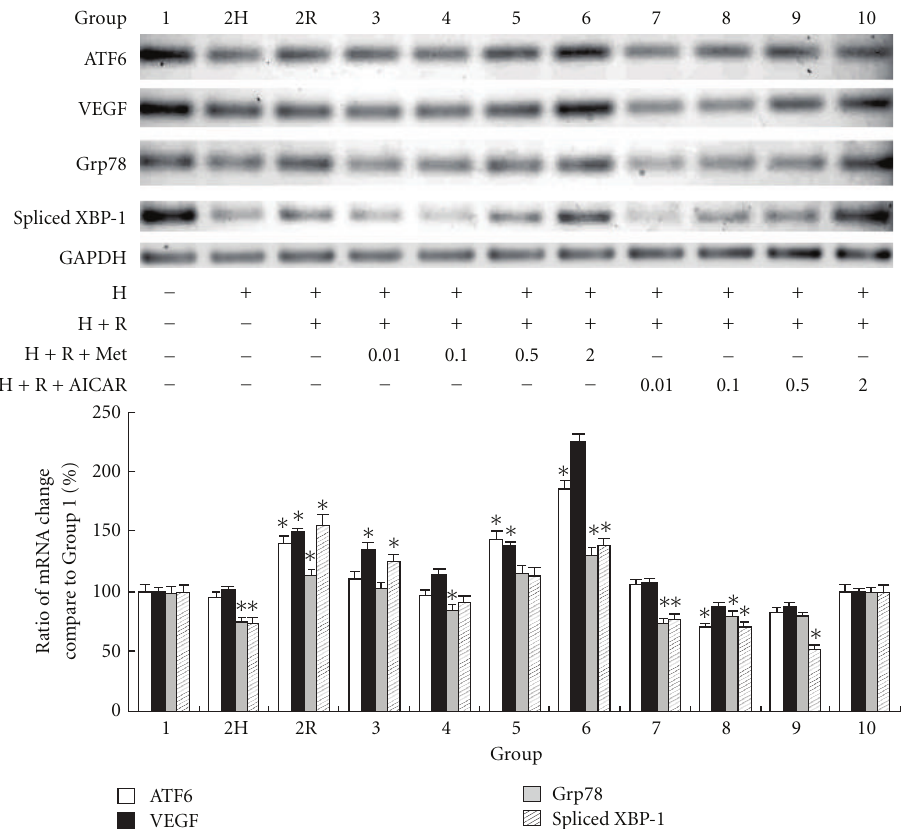
Figure 3: Reverse transcription PCR analysis showed up-regulation of ATF6, VEGF, Grp78, and spliced XBP-1 mRNAs in HL-1 cardiomyocytes from di ff erent groups. Glyceraldehyde-3-phosphate dehydrogenase (GAPDH) served as the loading control. The PCR products of GAPDH, ATF6, VEGF, Grp78, and spliced XBP-1 were designed to be around 200bp. Quantitative real-time PCR showed an elevated ratio of these mRNAs in various groups. (Results are representative of at least 3 separate experiments. ∗ P < . 05 compared with Group 1; H: hypoxia; R: reoxygenation; Met: